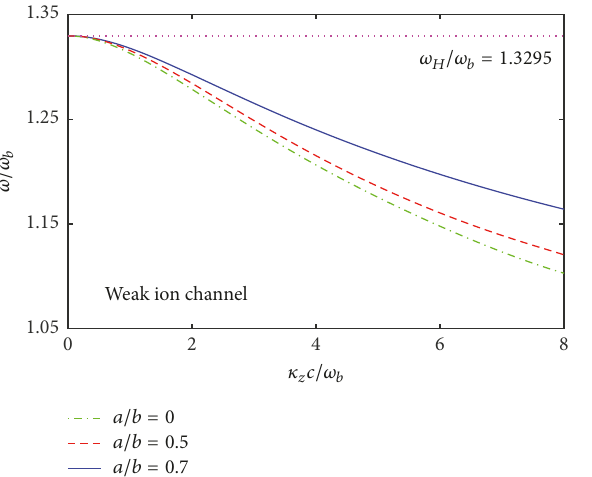
Figure 6: The effect of the ratio 𝑎/𝑏 on the dispersion curves of the SC 01 waves for weak ion channel with 𝜔 𝛽 = 0.8761 . The outer radius of the annular beam is taken as 0.5 R and 𝑎/𝑏 = 0 represents the solid beam case.